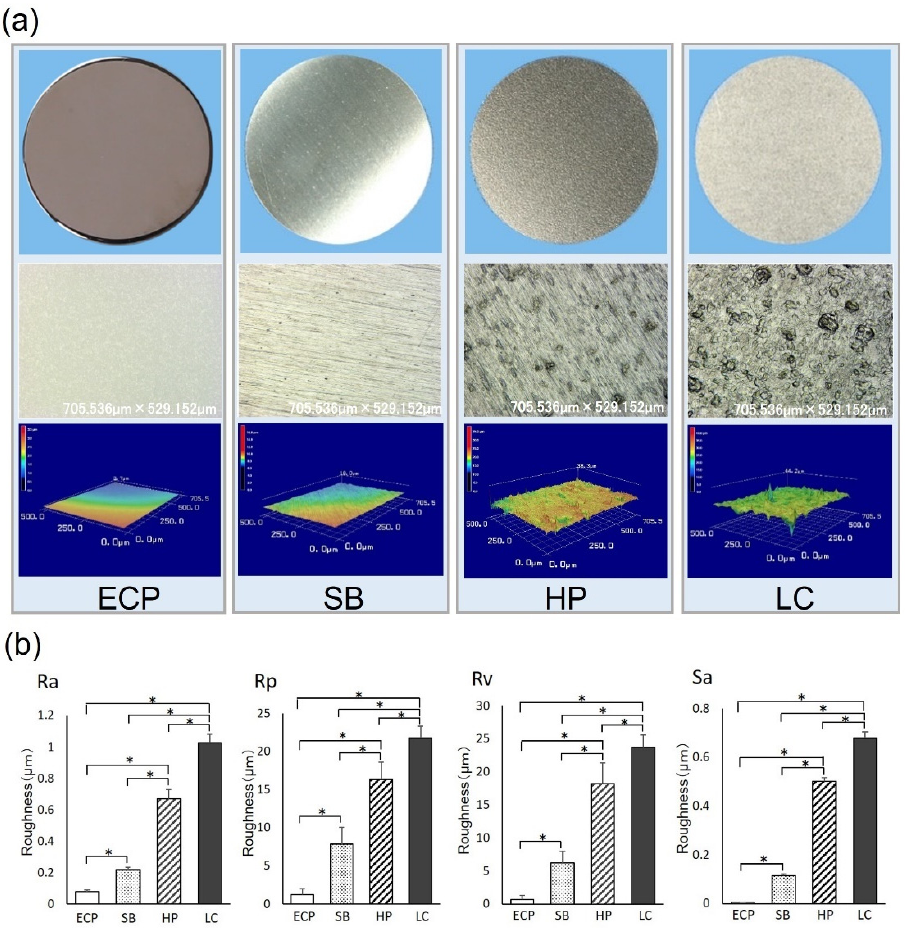
Figure 1. Properties of titanium surfaces with a smooth surface texture. ( a ) Top: Images of smooth titanium disks (20 mm diameter; ECP, SB, HP, LC). Middle: Scanning laser microscopy images. Bottom: The 3D images constructed from scanning laser microscopy images. ( b ) Histograms showing the surface roughness levels of Ra, Rp, Rv, and Sa. Data are presented as means ± SD ( n = 9). Note: * p < 0.05; statistically significant differences between ECP, SB, HP, and LC surfaces.